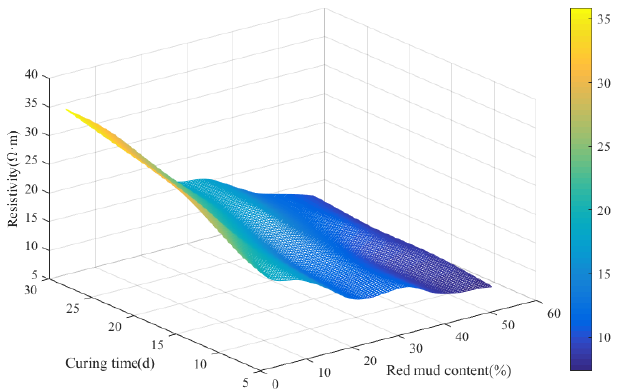
Figure 15. Three-dimension surface diagram of the correlations between red mud dosage, curing time, and electrical resistivity.